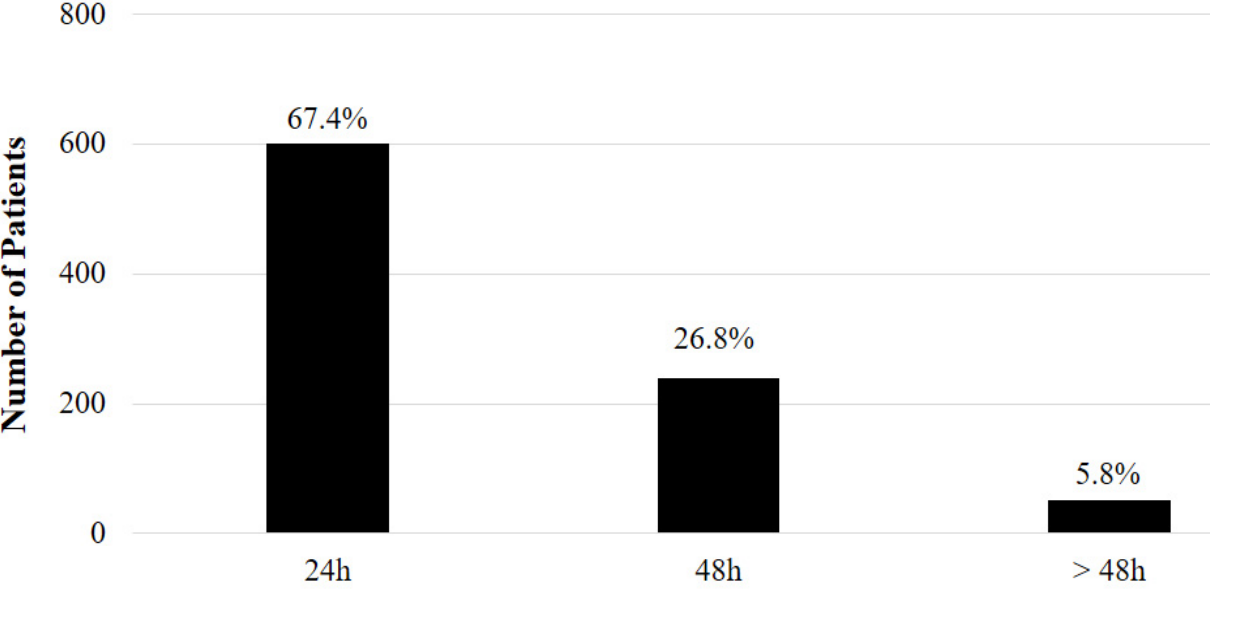
Figure 2. Prevalence of repeat medical emergency team after the first activation.